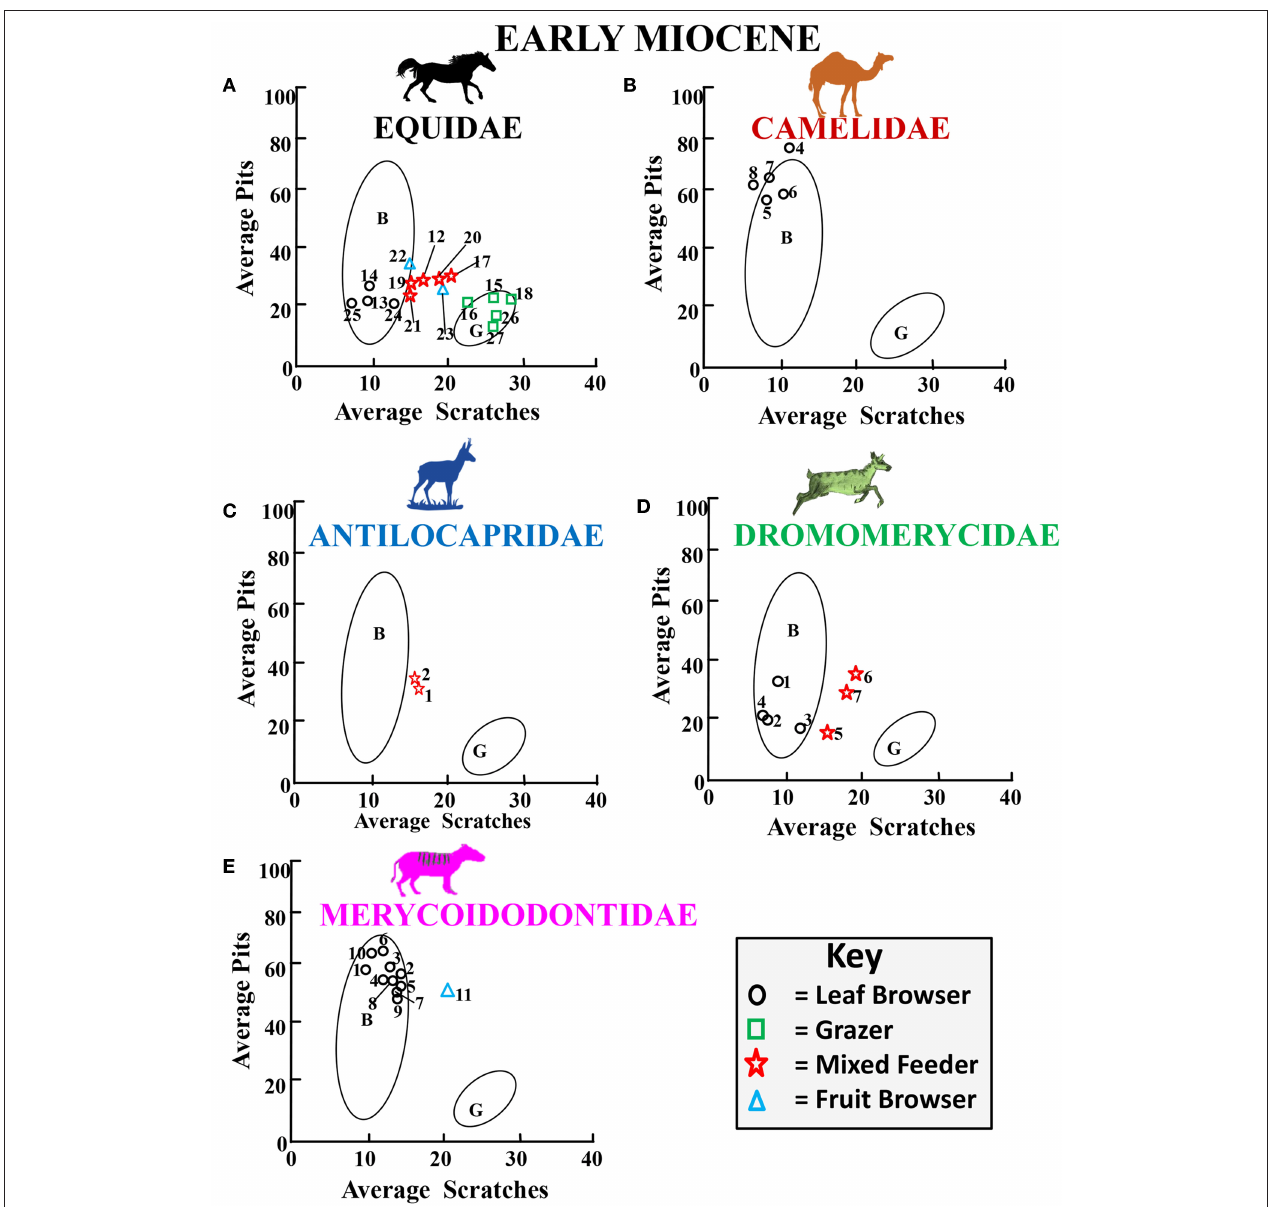
FIGURE 10 | Bivariate plot showing results for the average number of pits vs. the average number of scratches per taxon for Early Miocene fossil equids (A) , camelids (B) , antilocaprids (C) , dromomerycids (D) and merycoidodontids (E) plotted in reference to extant leaf dominated ungulate browsers (B), and extant grazers (G) at 35 times magnification (extant comparative data from Semprebon, 2002; Solounias and Semprebon, 2002). Gaussian confidence ellipses (p = 0.95) on the centroid are indicated for the extant leaf browsers and grazers (convex hulls) adjusted by sample size. Key to Equidae: 12,16, 17 = Parahippus nebrascensis , 13 = Kalobatippus agatensis , 14, 25 = Kalobatippus sp., 15, 18 = Parahippus sp., 19, 21 = Parahippus leonensis , 20 = Parahippus pawniensis , 22 = Archaeohippus blackbergi , 23 = Archaeohippus penultimus , 24 = Hypohippus sp., 26 = Merychippus primus , 27 = Acritohippus tertius . Key to Camelidae: 4 = Stenomylus hitchcocki